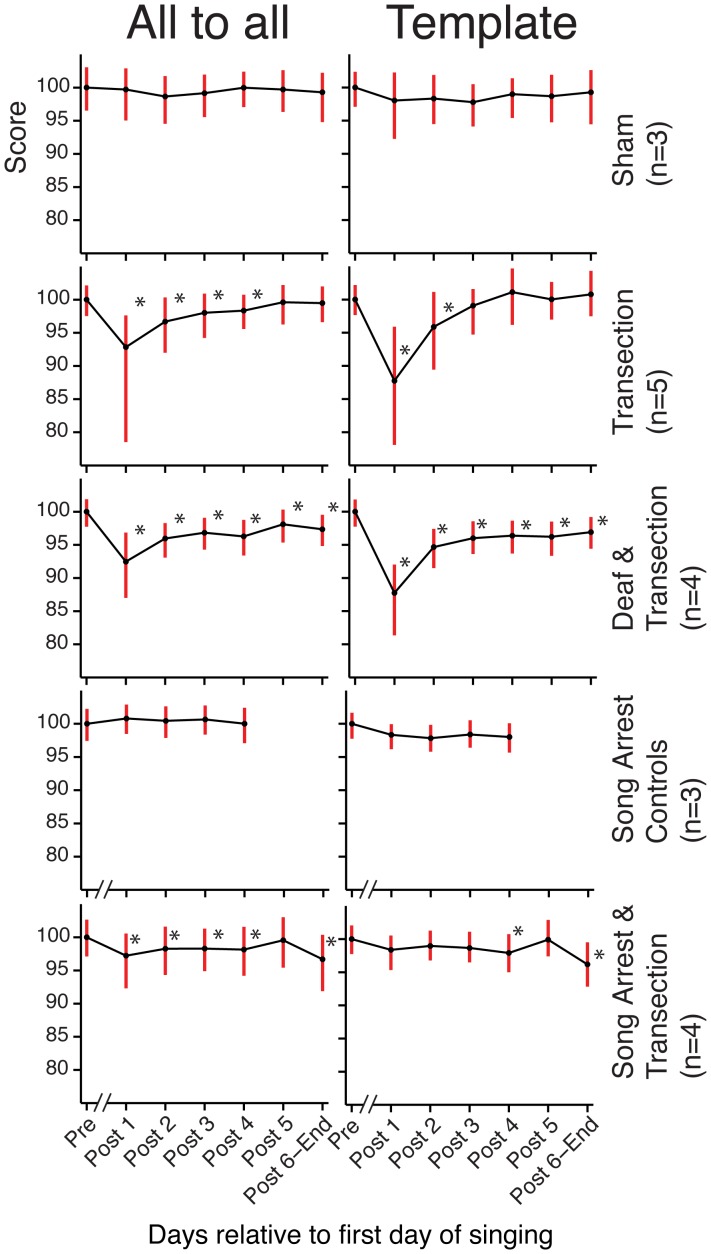
Aggregate grouped plots of similarity scores show the effects of HVC transection in all experimental conditions.(Left) “All-to-all” similarity scores were grouped across birds within each experiment condition into 6 time points: “Pre” is all data collected before the transection, and the time axis is relative to the first day of singing post surgery (either the first or second day post surgery). Median scores were normalized to reflect the percentage of the “Pre” point. (Right) Same plot for the “template” similarity scores. Error bars indicate the first and third quartiles. A break in the abscissa indicates the 4-day gap between the surgery and first post-transection song production for the “Song Arrest” conditions. For all statistical tests in this figure, * indicates p<.05 with Bonferonni correction, one-tailed Monte Carlo permutation test on the difference between medians relative to the sham (10,000 randomizations for each test).